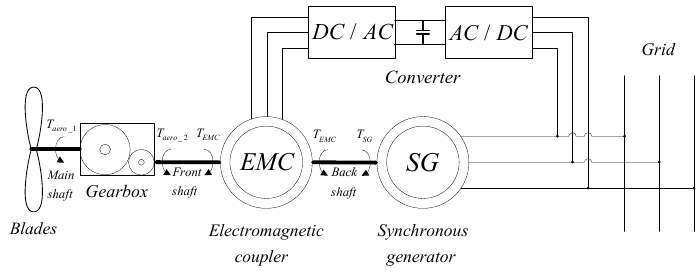
Figure 2. Schematic diagram of the wind turbine based on electromagnetic coupler’s (WT-EMC)